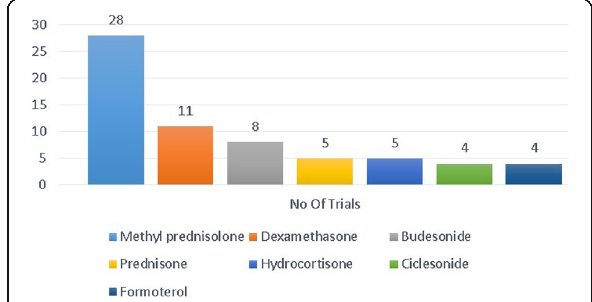
Fig. 3 Number of trials using different kinds of